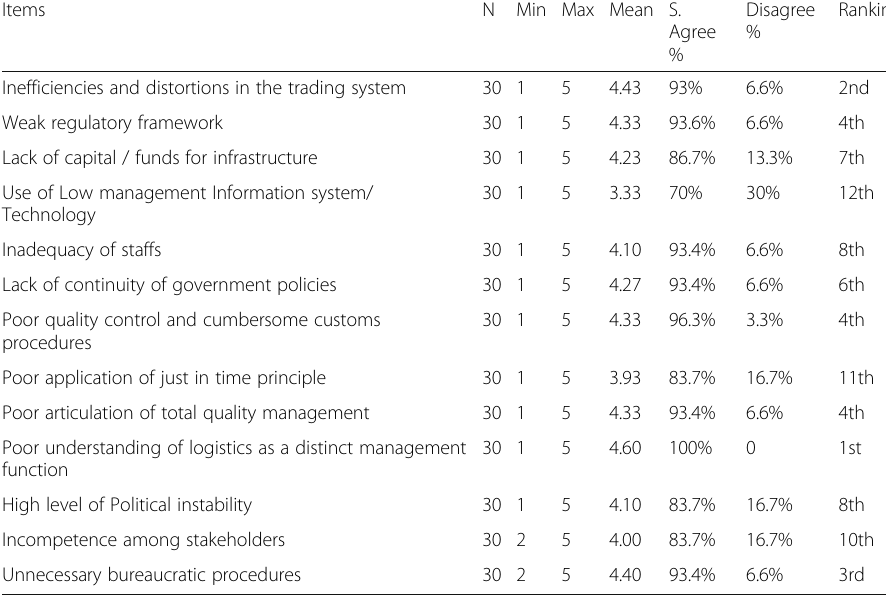
Table 13 Challenges of the Ghanaian freight transport system Items N Min Max Mean S.